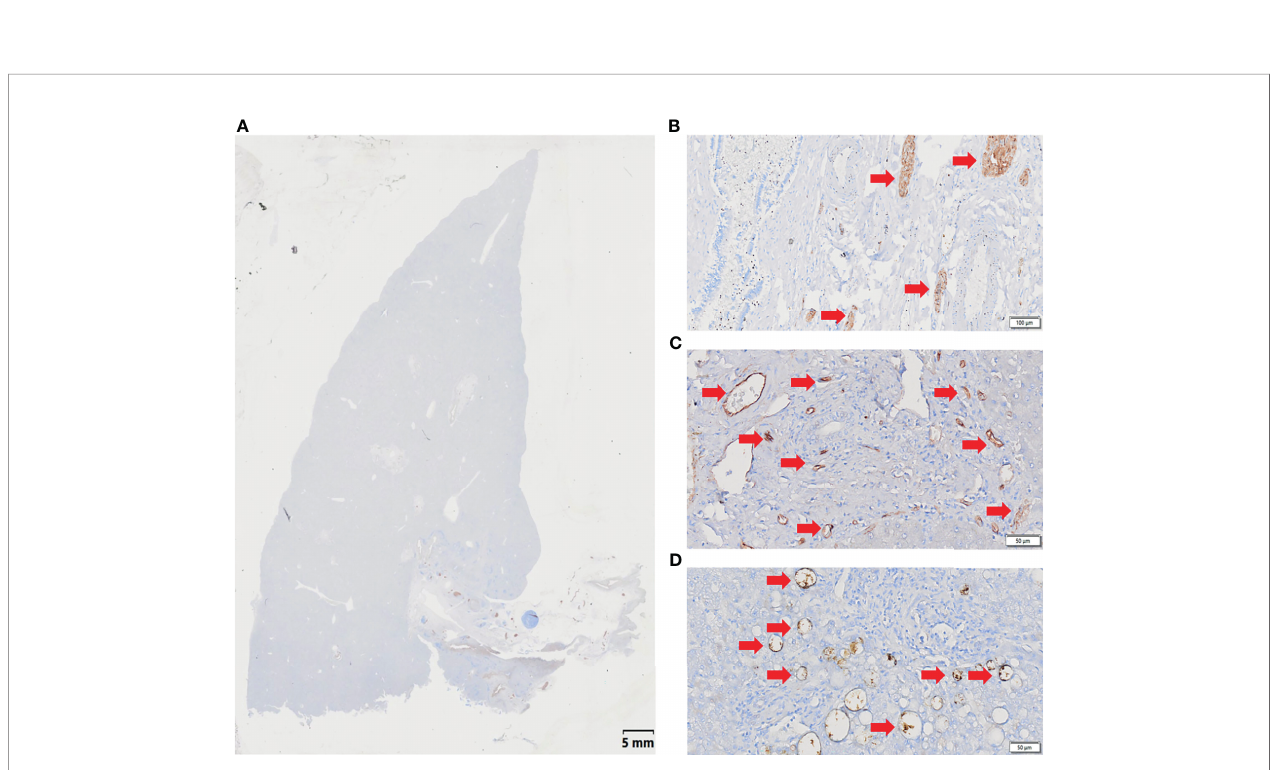
FIGURE 4 | Immunohistochemical (IHC) staining of WHLS in HCCA. (A) IHC staining. Scale bar, 5 mm. (B) S-100 staining demonstrates nerve distribution in the liver. The red arrows show nerve tissue. Scale bar, 50 µm. (C) CD34 staining demonstrates vascular distribution in the liver. The red arrows show blood vessels. Scale bar, 100 µm. (D) D2-40 staining demonstrates lymphatic distribution in the liver. The red arrows show lymphatic vessels. Scale bar, 50 µm.